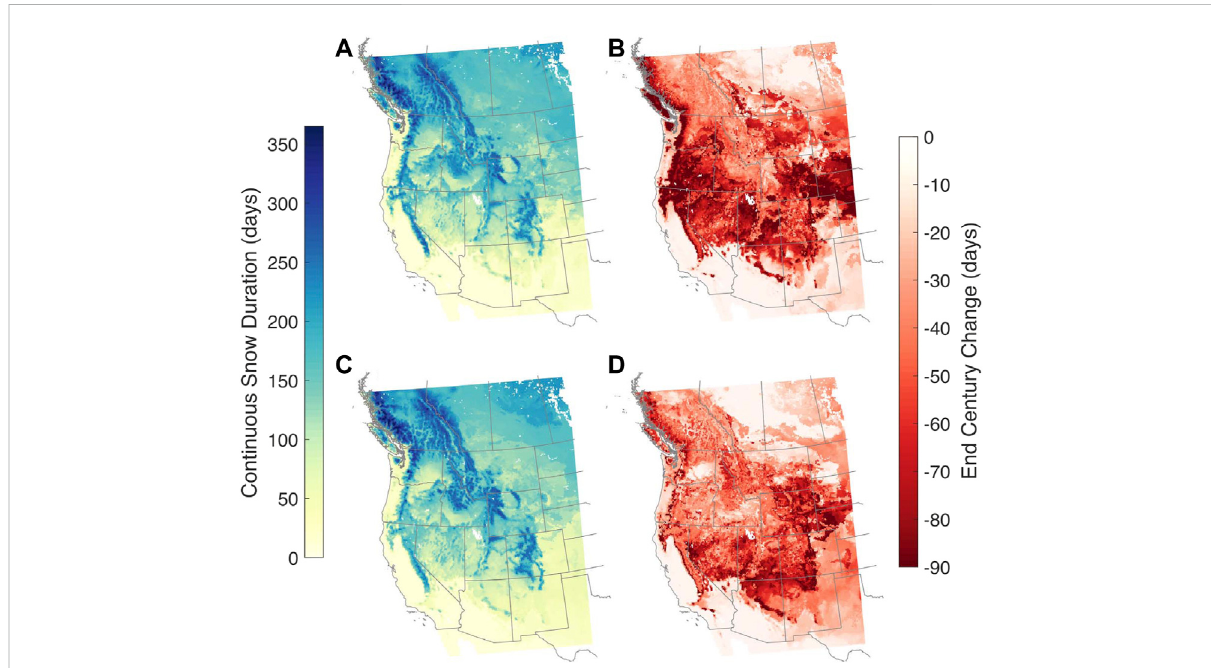
FIGURE 9 As for Figure 4 but for continuous snow duration. (A,B) are for WRF/CCSM and (C,D) are for